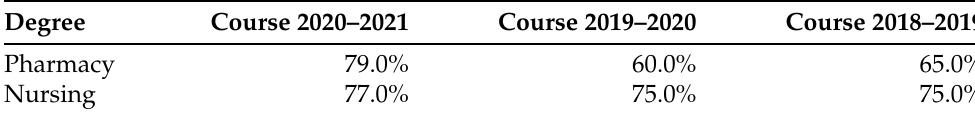
Table 16. Average seminar